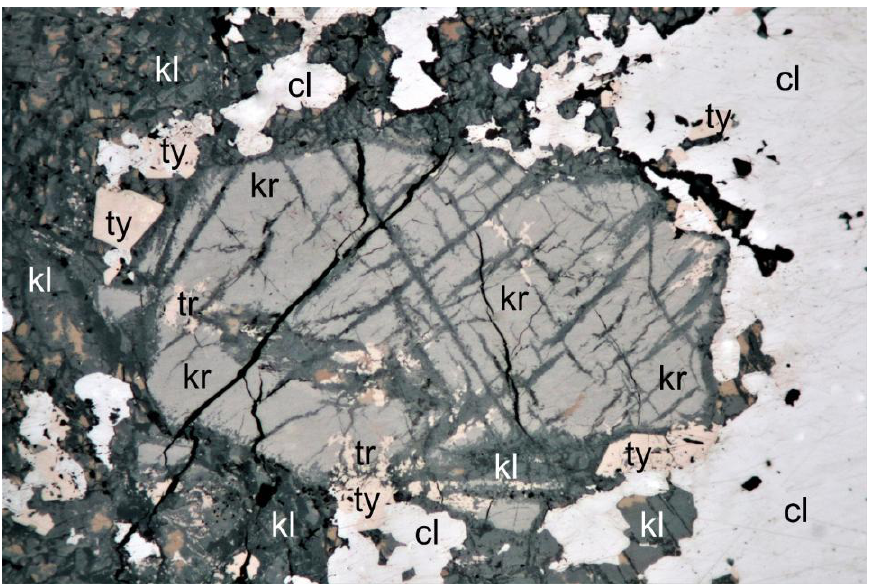
Figure 9. Detail from Se vein Type 3: Replacement relics of krut’aite-(g1) (kr). The original rectangular shapes of the krut’aite crystals are outlined by patchily distributed trogtalite-(g1) (tr) and tyrrellite (g2) (ty). Other replacement and alteration products are klockmannite-(g2) (kl), eskebornite-(g2) (brown spots) and clausthalite-(g2) (cl). Reflected light image, 500-μm-wide, plane polarized light.